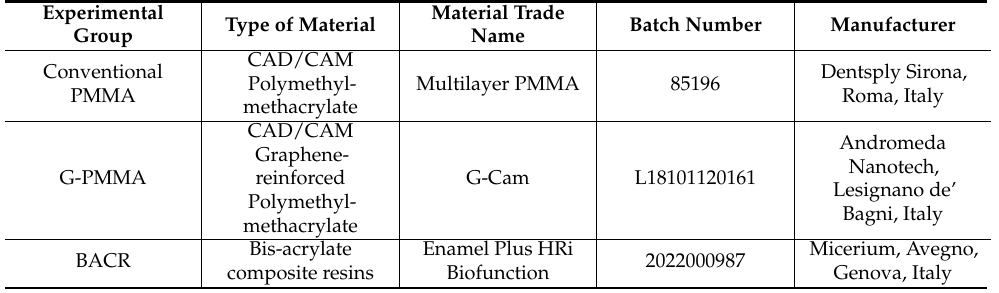
Table 1. Summary of the materials tested.